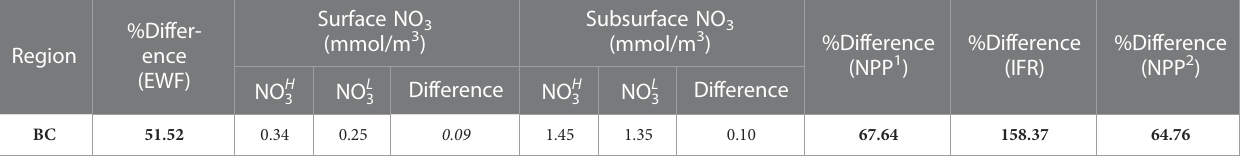
Bold and italic values indicate p< 0.05 and p< 0.19, respectively; others mean non-signi fi cant. NO H 3 : the mean of the NO 3 in high EWF years; NO L 3 : the mean of the NO 3 in low EWF years; Difference: NO